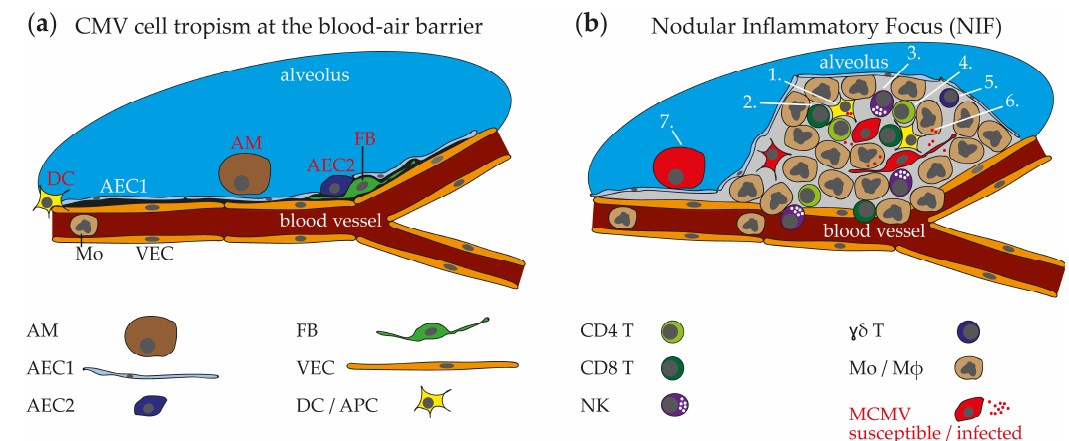
Figure 1. Microanatomy of mouse cytomegalovirus (MCMV) pneumonitis: ( a ) MCMV cell tropism at the blood-air barrier. Alveolar macrophages (AM), type 2 alveolar epithelial cells (AEC2), fibroblast-